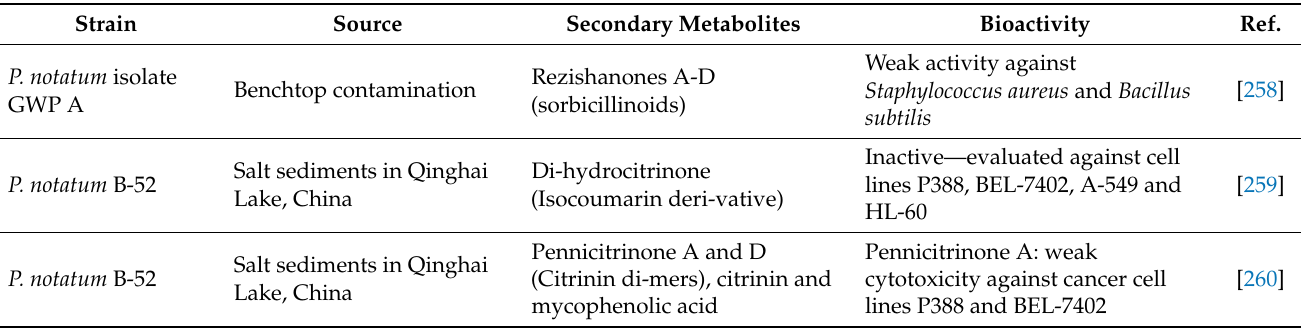
Table 1. Secondary metabolites isolated from different P. chrysogenum strains and their analyzed